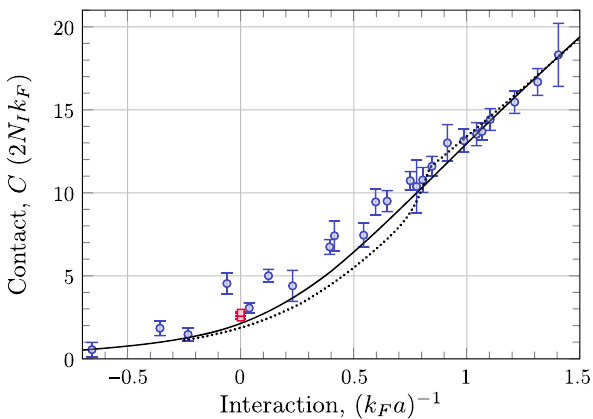
FIG. 6. Measured Tan contact. The contact coefficient C is shown for different interaction strengths, obtained using Eq. (18) ¯ Z with E b and extracted from the Raman spectra. The theory for a single impurity at zero temperature predicts a discontinuous change in C at the polaron-to-molecule transition [38]. While this discontinuity is smoothed when averaged for a harmonically trapped gas using the LDA (dotted line), an abrupt change is expected to remain. The data significantly deviate from this prediction. Instead, they agree well with our calculation taking into account the finite temperature and coexistence of polarons and molecules (solid line); see Sec. VI. The two red squares indicate data measured by the MIT group [11] using rf spec- troscopy of a unitary, homogeneous 6 Li gas at T ¼ 0 . 17 T F (lower point) and T ¼ 0 . 29 T F (upper